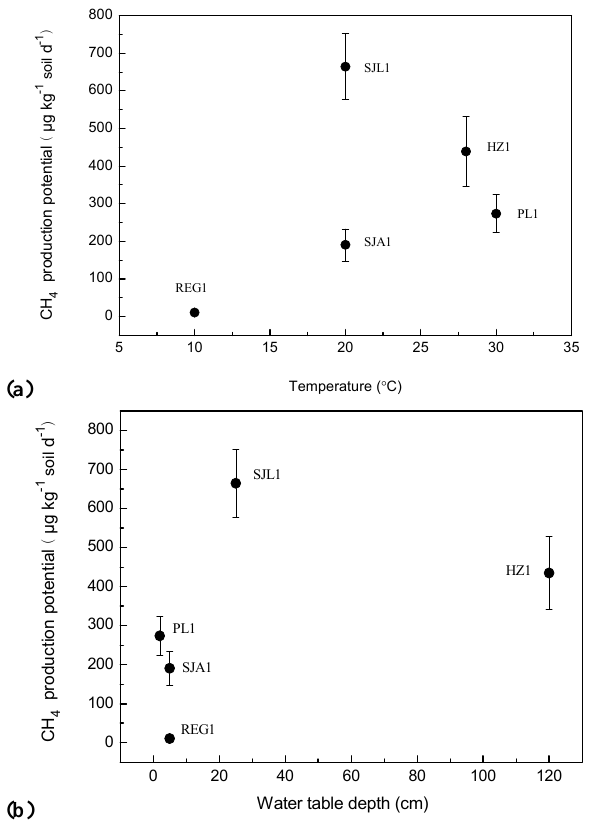
Fig. 3. Relationship between CH 4 production potential of the top soil layer in different wetlands across China and incubation temper- ature (a) , or the water table depth (b) . Vertical bars denote standard errors of means ( n = 3). SJA1 = 0–20cm soil in the Sanjiang Plain C. angustifolia marsh, SJL1 = 0–30cm soil in the Sanjiang Plain C. lasiocarpa marsh, HZ1 = 0–20cm soil in the Hongze wetland, PY1 = 0–10cm soil in the Poyang wetland, and REG1 = 0–10cm soil in the Ruoergai peatland.